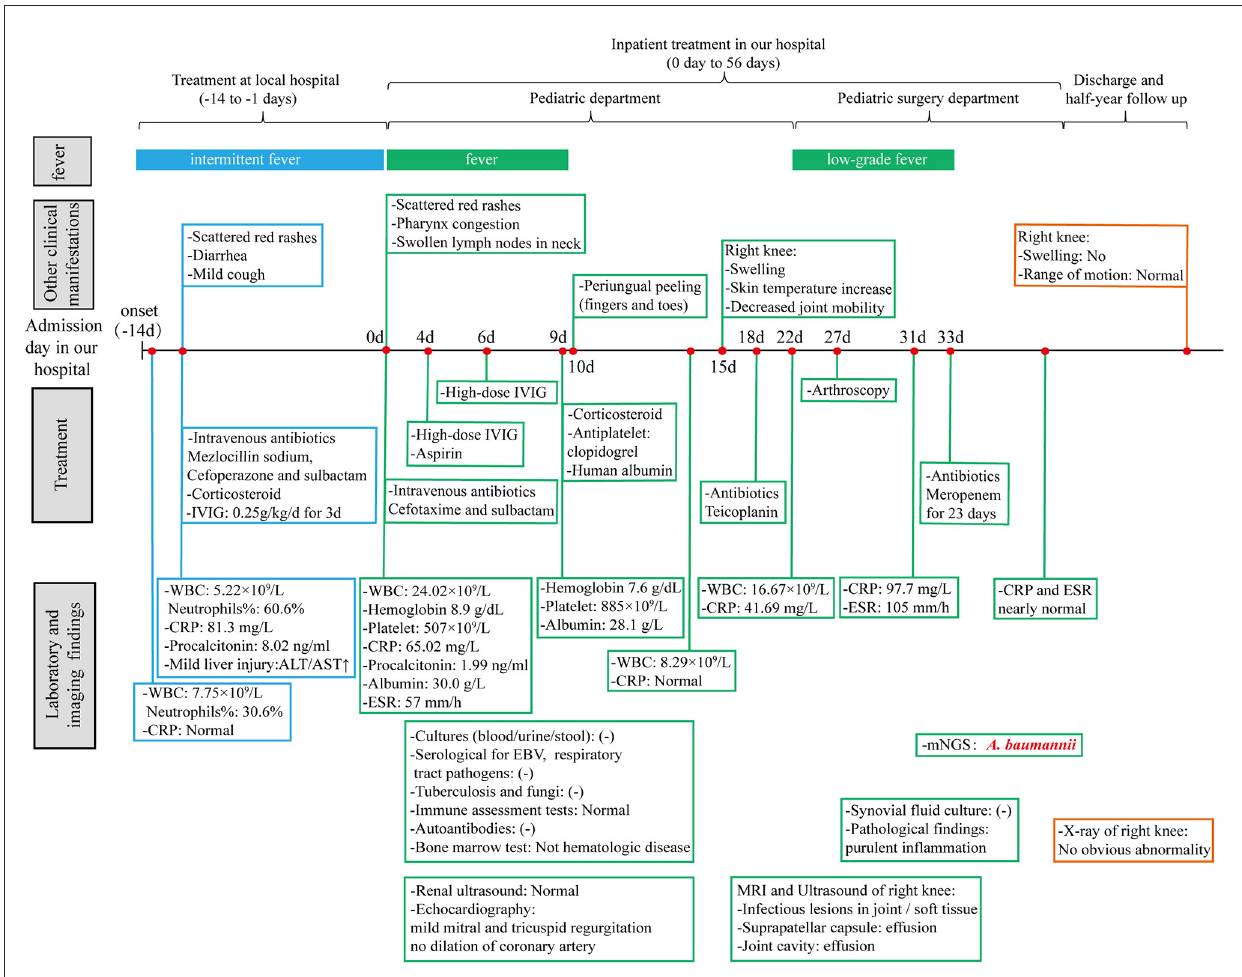
FIGURE3 A timeline with relevant data from the patient’s episode of care. WBC, white blood cell; CRP, C-reactive protein; ALT, alanine aminotransferase; AST, aspartate aminotransferase; IVIG, intravenous immunoglobulin; ESR, erythrocyte sedimentation rate; EBV, Epstein-Barr virus; mNGS, metagenomics next-generation